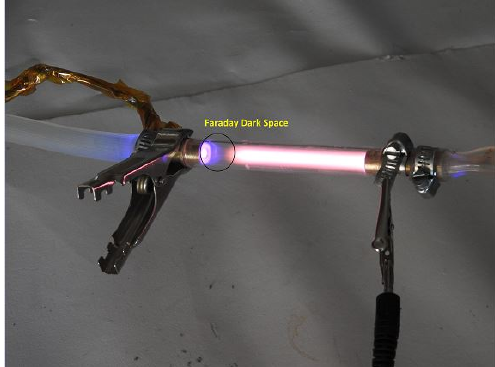
Figure 9. Experimental demonstration of DC glow discharge.